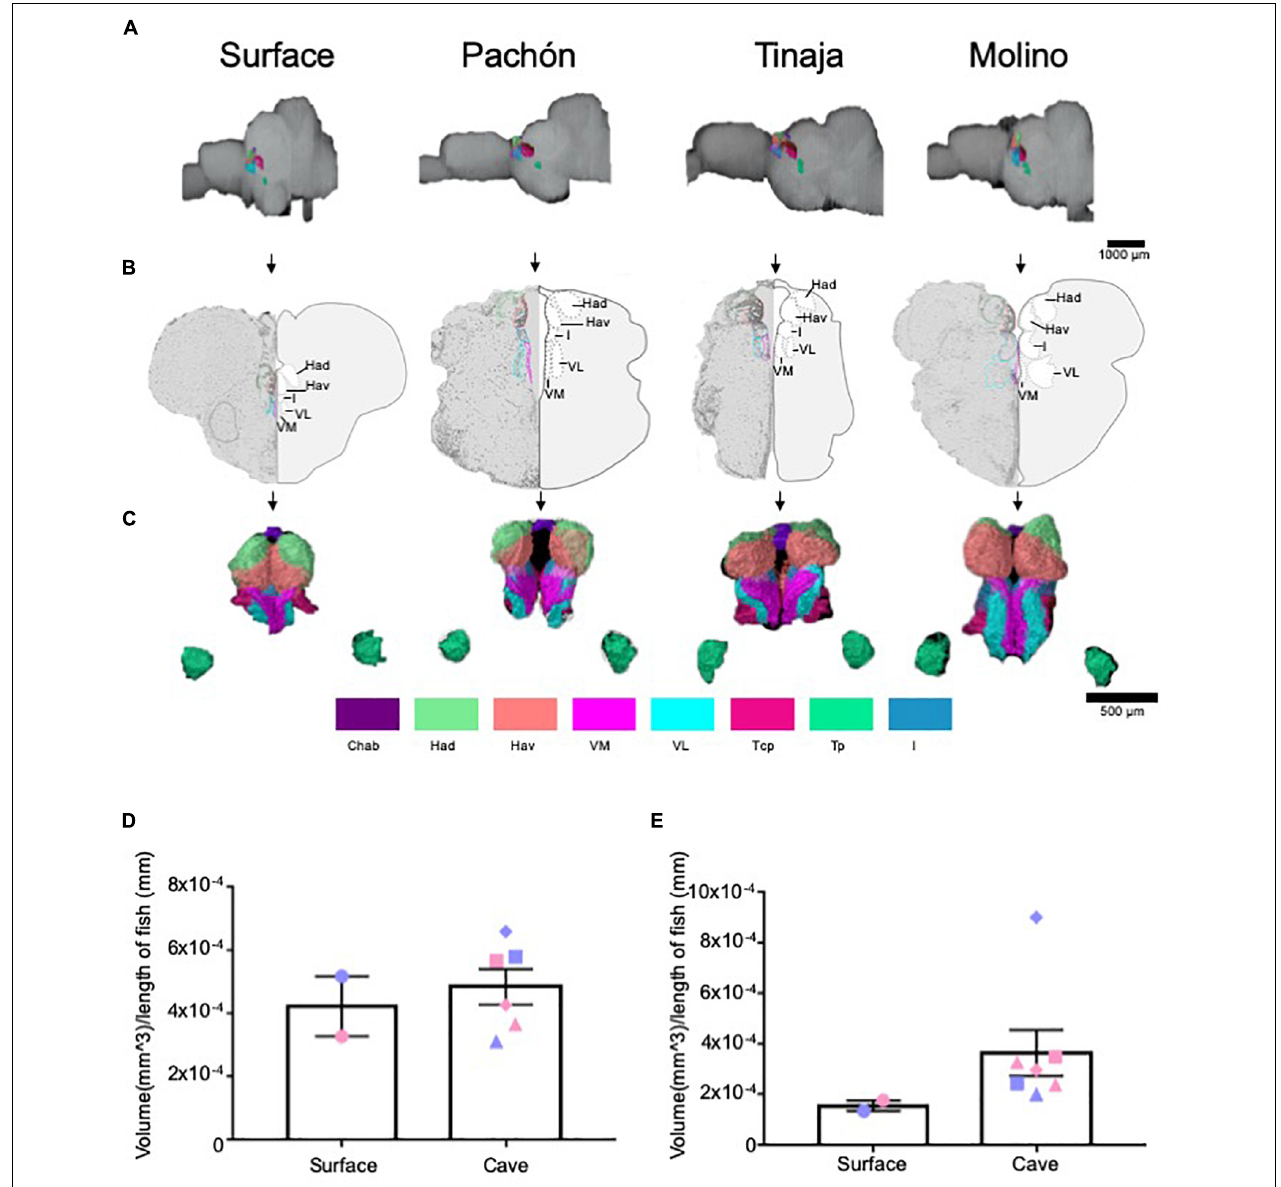
FIGURE 4 | Quantification of the thalamus and habenulae reveals differences in some, but not all, subnuclei. (A) 3-D reconstructions of Surface, Pachón, Tinaja, and Molino with demarcated thalamus and habenula displayed. (B) Images of demarcated sections that were Nissl stained (left) and a cartoon of demarcated region (right). (C) 3-D reconstruction of subnuclei of the thalamus and habenulae, displayed from an anterior view. (D) Quantification of the total volume of the thalamus revealed no significant differences (surface fish 0.0004 ± 0.0001, cavefish 0.005 ± 0.0001, t -test t = 0.5519, df = 6, p = 0.30). (E) Quantification of the total volume of the habenulae revealed no significant differences (surface fish 0.00015 ± 0.00002, cavefish 0.0003 ± 0.00009, t -test t = 1.161, df = 6, p = 0.14). Graphs in panel (D,E) are the mean ± standard error of the mean. Color key for subnuclei (Chab = Habenula Commissure, Had = Dorsal Habenular Nucleus, Hav = Ventral Habenular Nucleus, VM = Ventromedial Prethalamus, VL = Ventrolateral Prethalamus, Tcp = Central posterior thalamic nucleus, Tp = Posterior thalamic nucleus, I = Intermediate Prethalamus). Blue points on bar graphs denote males, whereas light red denotes female. Square points on graphs represent Pachón, triangle points on graph represent Tinaja and diamond points on graph represent